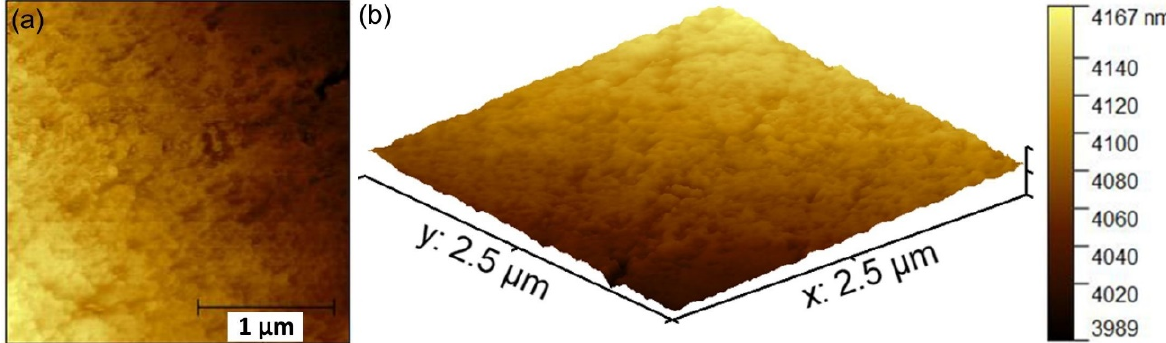
Figure 7. 2D atomic force microscopy (AFM) topography of NBrHAp coatings ( a ) and 3D representation of the NBrHAp coatings ( b ) surface collected on an area of 2.5 × 2.5 µm 2 .